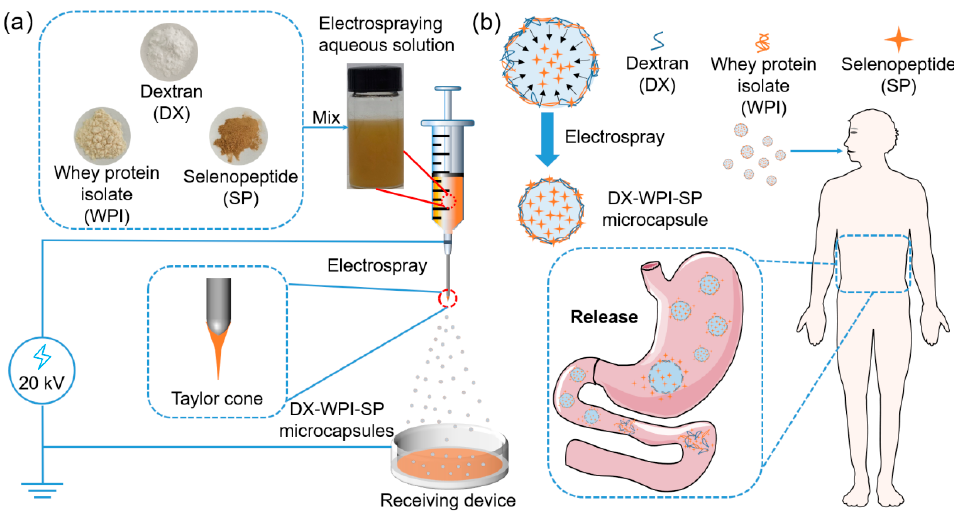
Figure 1. ( a – c ) Optical images and particle size distribution of DX-WPI-SP microcapsules with dif- ferent DX/WPI/SP mass ratios (a—6:4:9, b—6:6:9, c—6:8:9). ( d ) The average particle size and ( e )